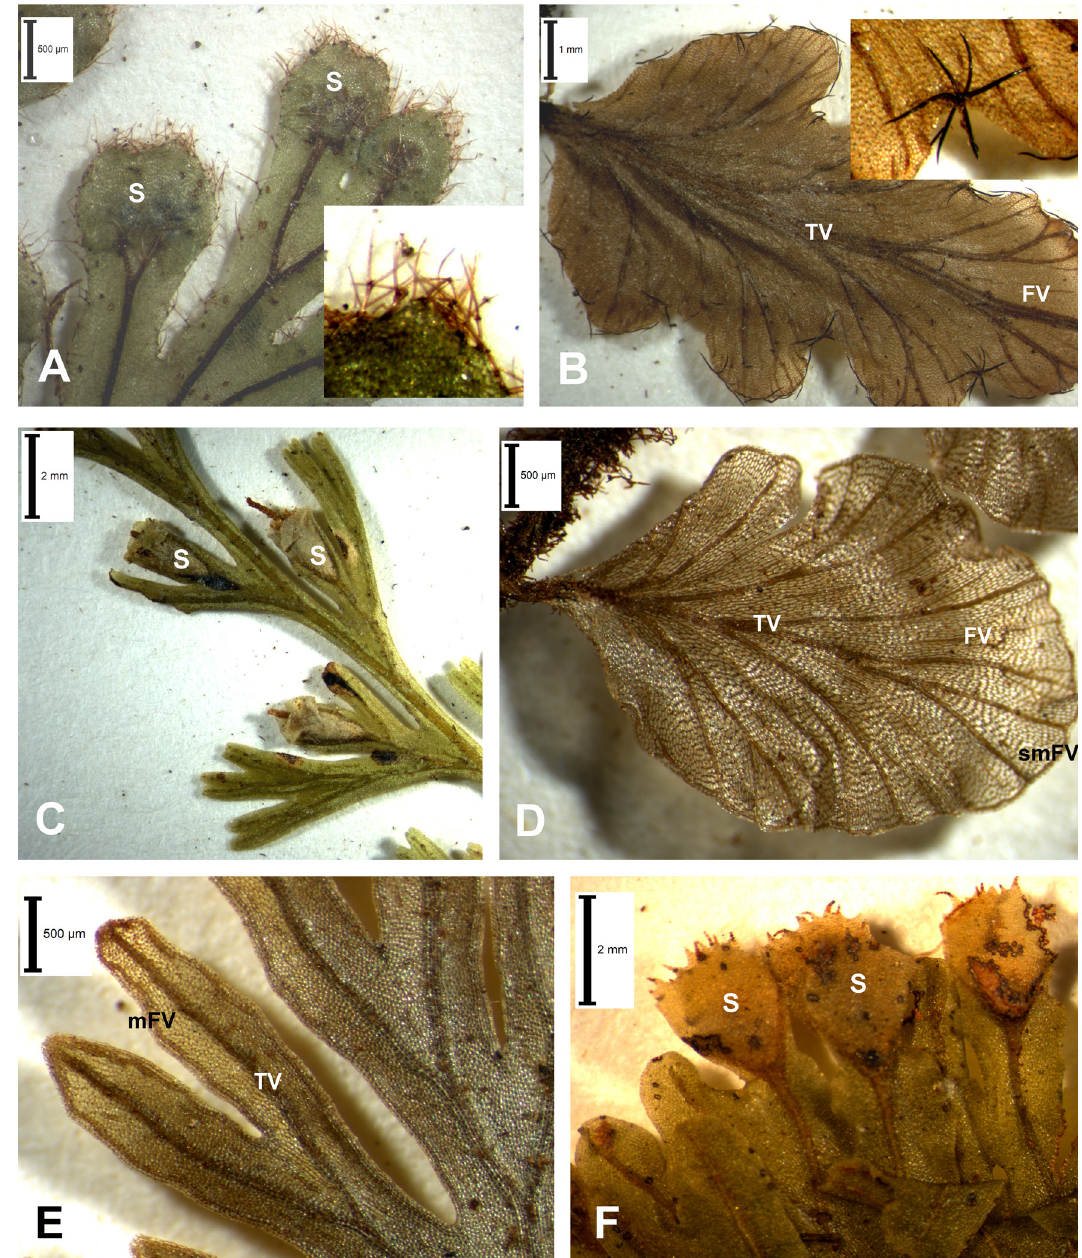
Fig. 2. Illustration of representative descriptors and states used in the Xper database (see Appendix 1). A . Hymenophyllum hirsutum (L.) Sw., typical bilabiate sori (S) without a developed base, fully hairy lamina with pedunculated brown trichomes (see inset). B . Didymoglossum robinsonii (Hook. ex Baker) Copel., false veins (FV) parallel but not connected to true veins (TV) and marginal dark trichomes clustered here by 6 (see inset). C . Crepidomanes inopinatum (Pic.Serm.) J.P.Roux, typical trichomanoid sori (S) with a developed tubular base, lips are here dilated as a collar. D . Didymoglossum rotundifolium (Bonap.) J.P.Roux, false veins (FV) parallel but not connected to true veins (TV) and continuous submarginal false vein (smFV), here the one-cell thick lamina appears well translucent. E . Crepidomanes bipunctatum (Poir.) Copel., false veins more or less continuous and parallel to margins (mFV) and not connected to true veins (TV). F . Hymenophyllum sibthorpioides (Bory ex Willd.) Mett. ex Kuhn, bilabiate sori (S) with toothed margins. Photographs by A.H.